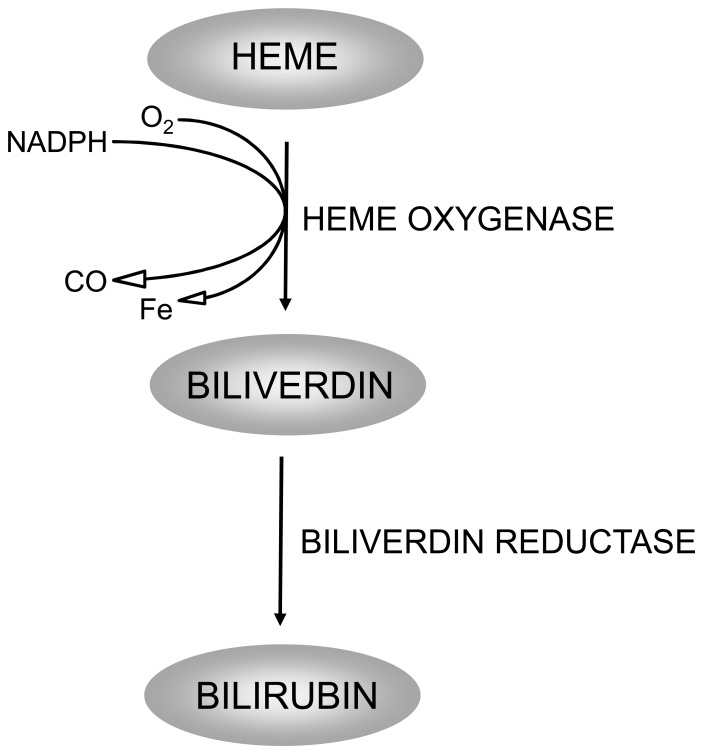
Heme catabolic pathway.Heme oxygenase, the rate limiting enzyme in the heme catabolic pathway, catalyzes oxidative degradation of heme to form equimolar amounts of bioactive products carbon monoxide, iron and biliverdin, which is subsequently reduced to bilirubin by biliverdin reductase.